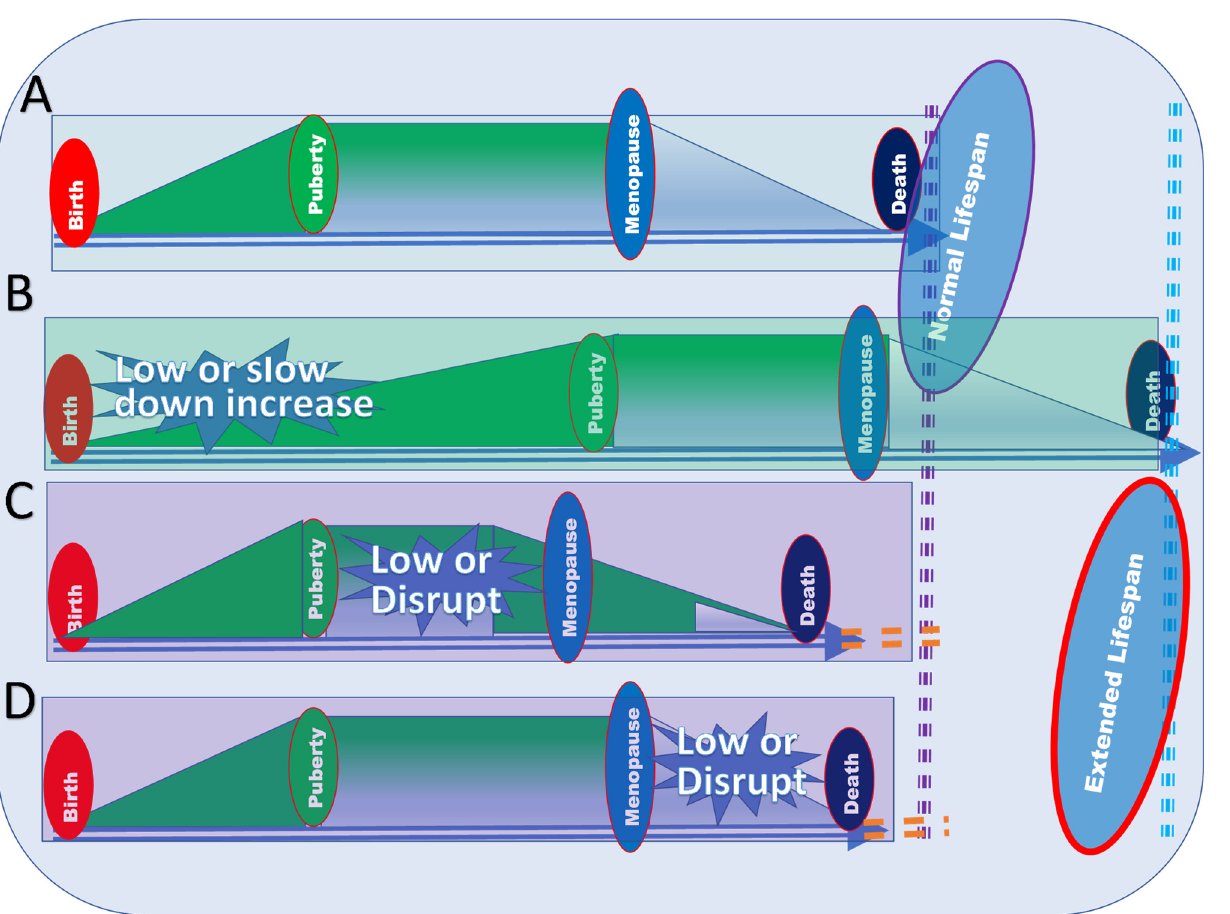
Figure 2. Hypothetic effects of estrogen in different life stages on females: ( A ) the life stages and normal lifespan in females; ( B ) the extension of the growth and reproductive life stages by lowering or slowing down the increase in estrogen before puberty; ( C ) the shortening of the reproductive life stage and lifespan using oophorectomy after puberty and before menopause; ( D ) the elimination of the production of estrogen and shortening of the lifespan using oophorectomy performed after menopause.